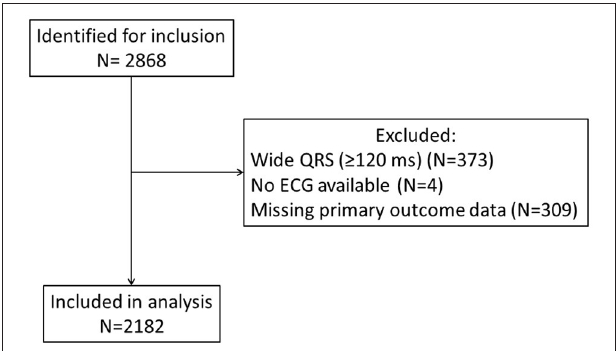
FIGURE 1 | Flow chart summarizing the inclusion and exclusion of patients.